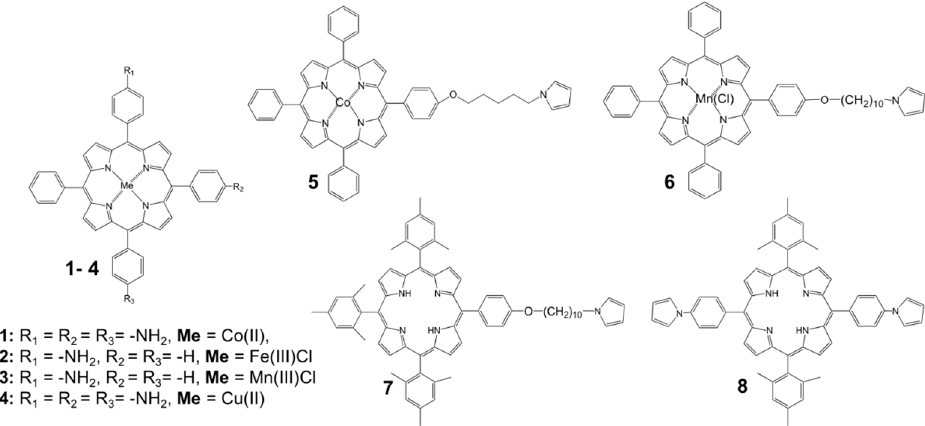
Figure 1. Chemical structures of porphyrin monomers employed in e-Tongue array.